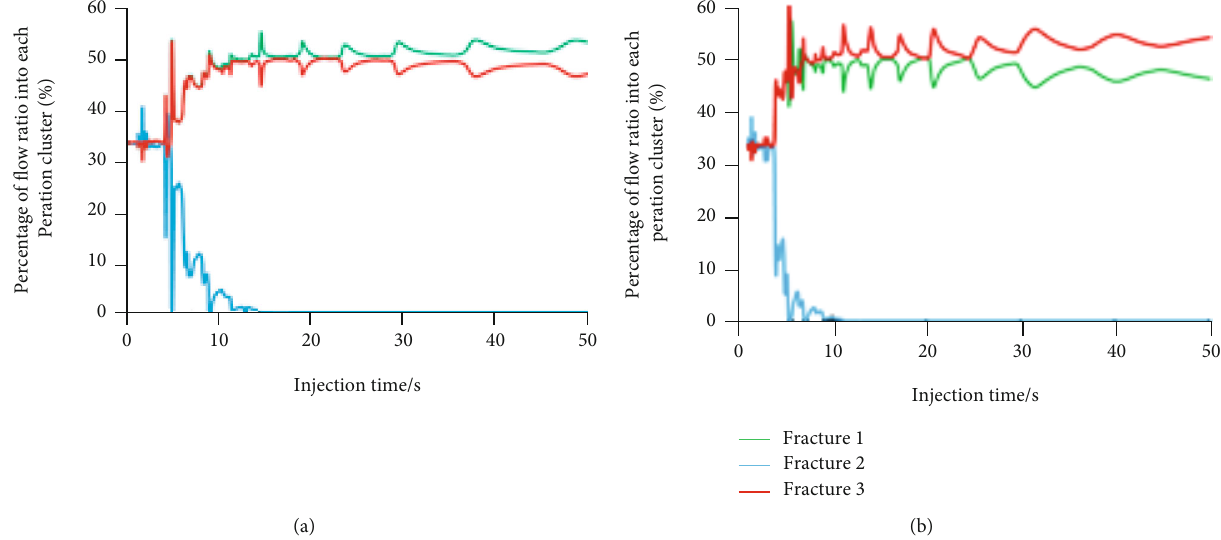
Figure 8: Percentage of fl ow into each cluster as a function of time for di ff erent fl ow rates: (a) case 1 (6 m 3 /min); (b) case 2 (10 m 3